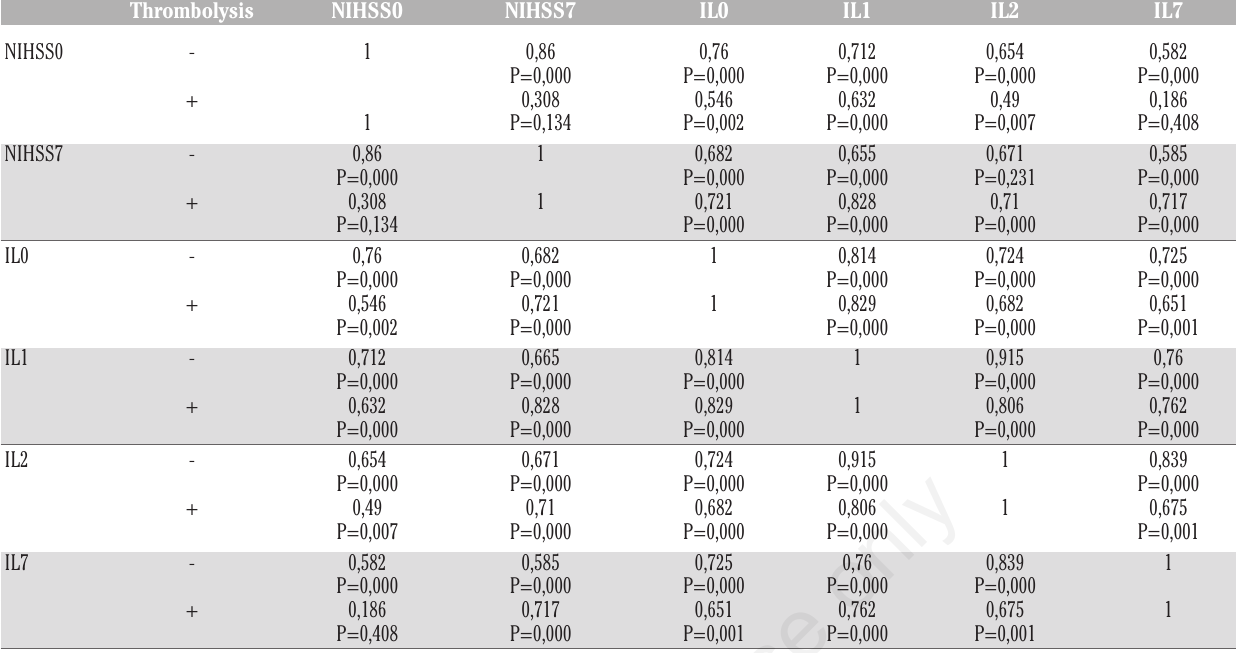
Table 3. Associations of NIHSS score at admission and at day seven and IL-10 values at admission, 24 hours, 48 hours and seven days after admission in both groups of patients. Thrombolysis